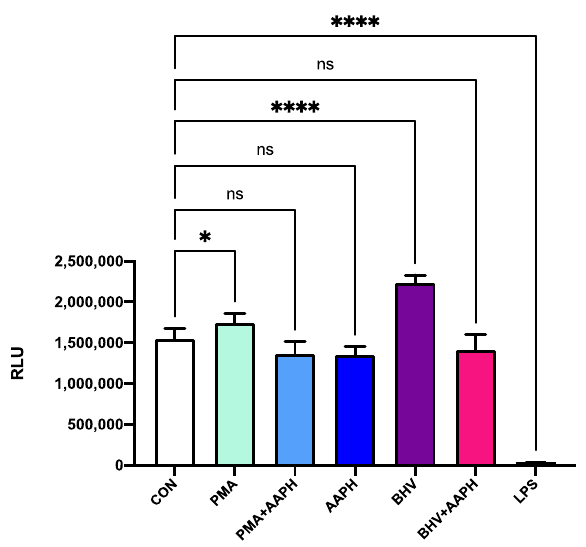
Figure 4. Viability of PBMCs after 12 h of incubation with the different treatments. Results are expressed as estimated means ± SEM of relative luminesce units (RLU). CON = Untreated peripheral mononuclear blood cells (PBMCs); PMA = PBMCs treated with 10 ng/mL phorbol 12-myristate 13-acetate (PMA) and 1 µ g/mL ionomycin; PMA + AAPH = PBMCs treated with 10 ng/mL PMA, 1 µ g/mL ionomycin, and 3 mM of 2,2 ′ -Azobis(2-amidinopropane) dihydrochloride (AAPH); AAPH = PBMCs treated with 3 mM AAPH; BHV = PBMCs treated 8 × 10 4 TCID 50 Bovine Herpesvirus 1 per 1 × 10 6 PBMCs; BHV + AAPH = PBMCs treated 8 × 10 4 TCID 50 Bovine Herpesvi- charide (positive control). Differences between treatments and the control were assessed with